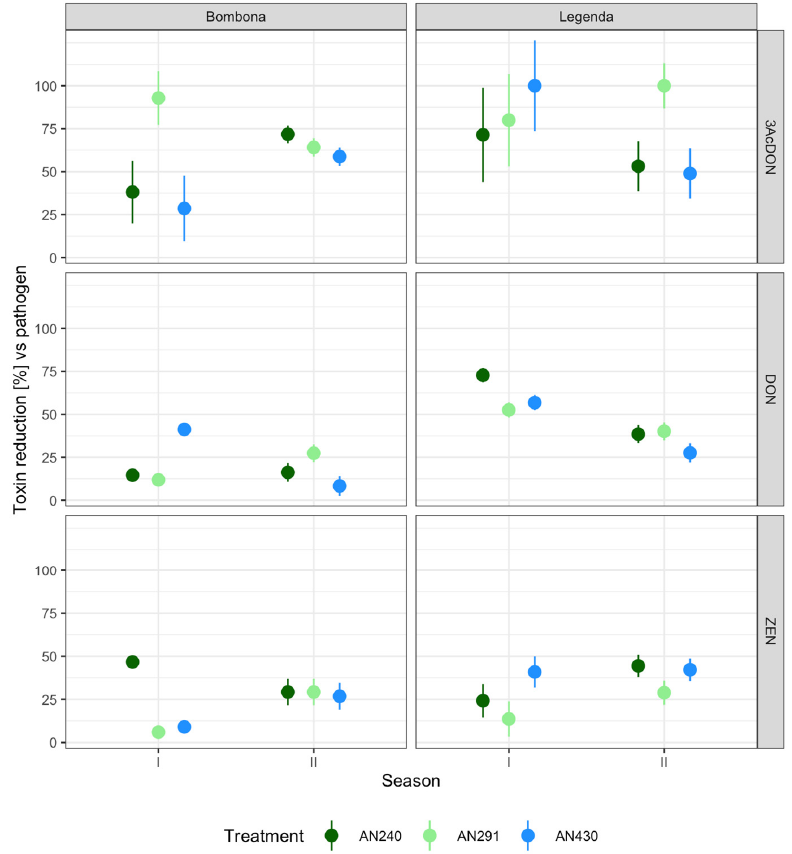
Figure 10. The differences (%) in toxin contents compared to the control (inoculation by pathogen